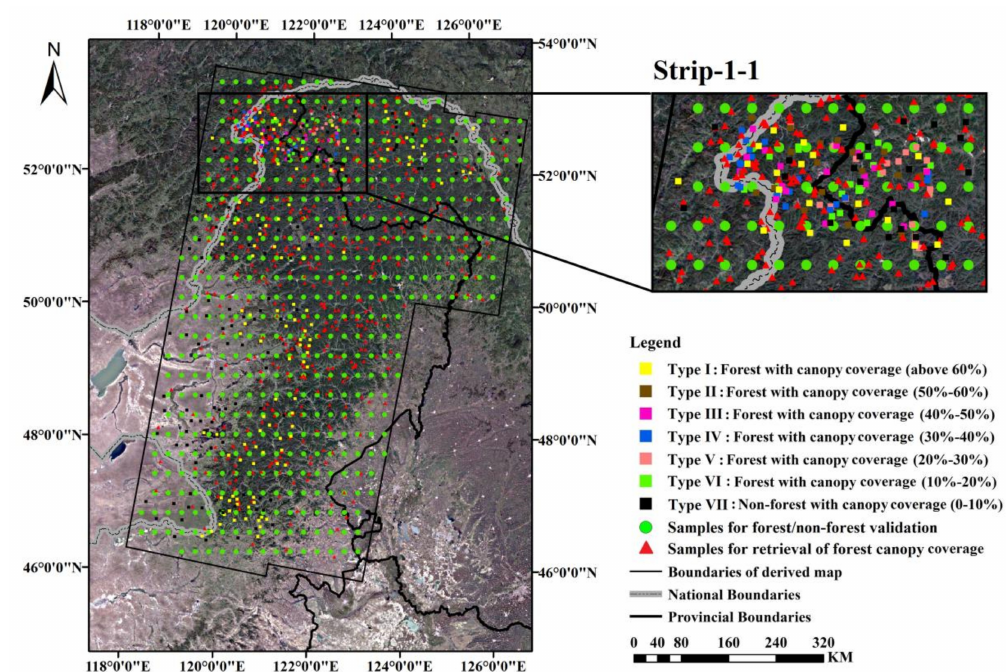
Figure 4. Spatial distributions of sampling plots used in this study. The background is Google Earth TM image with black polygons indicating the spatial coverage of Sentinel-1 images. The squares, circles, and triangles with di ff erent colors indicate di ff erent types of sampling